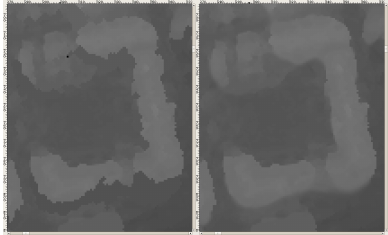
Figure 18: Detail of filled DSM (left) and IDW interpolated DSM